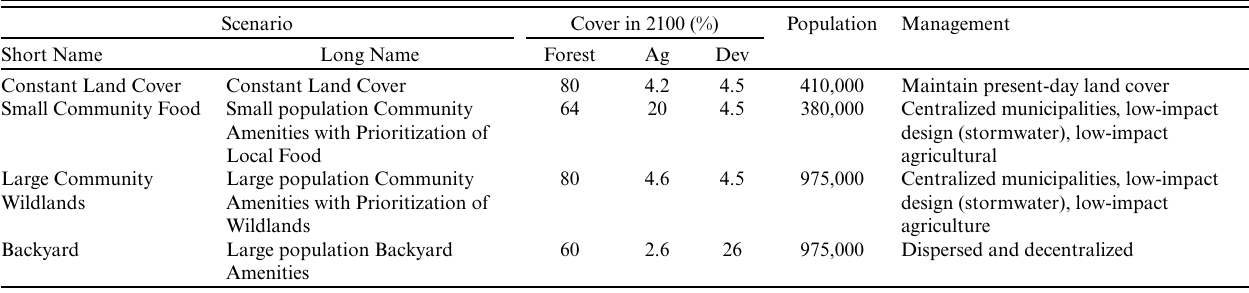
Table 1. Statistical details of different land-cover scenarios used in this study (based on Thorn et al. 2017).